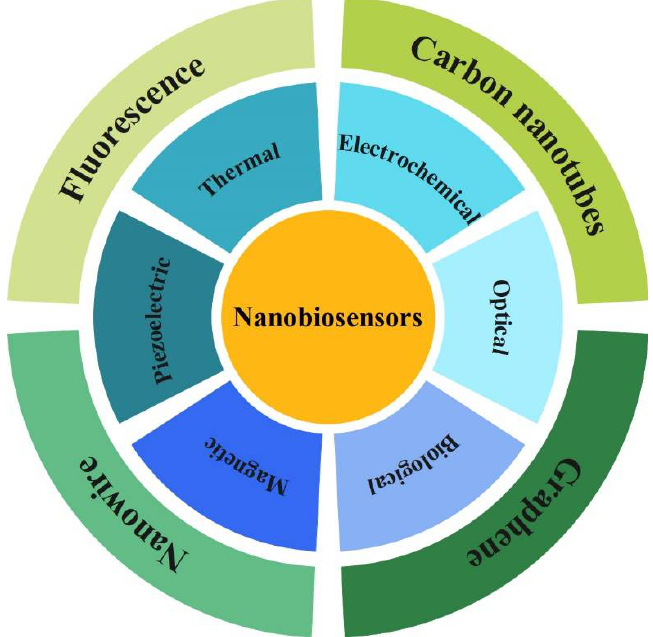
Figure 2. Classification of nanobiosensors for viral detection.